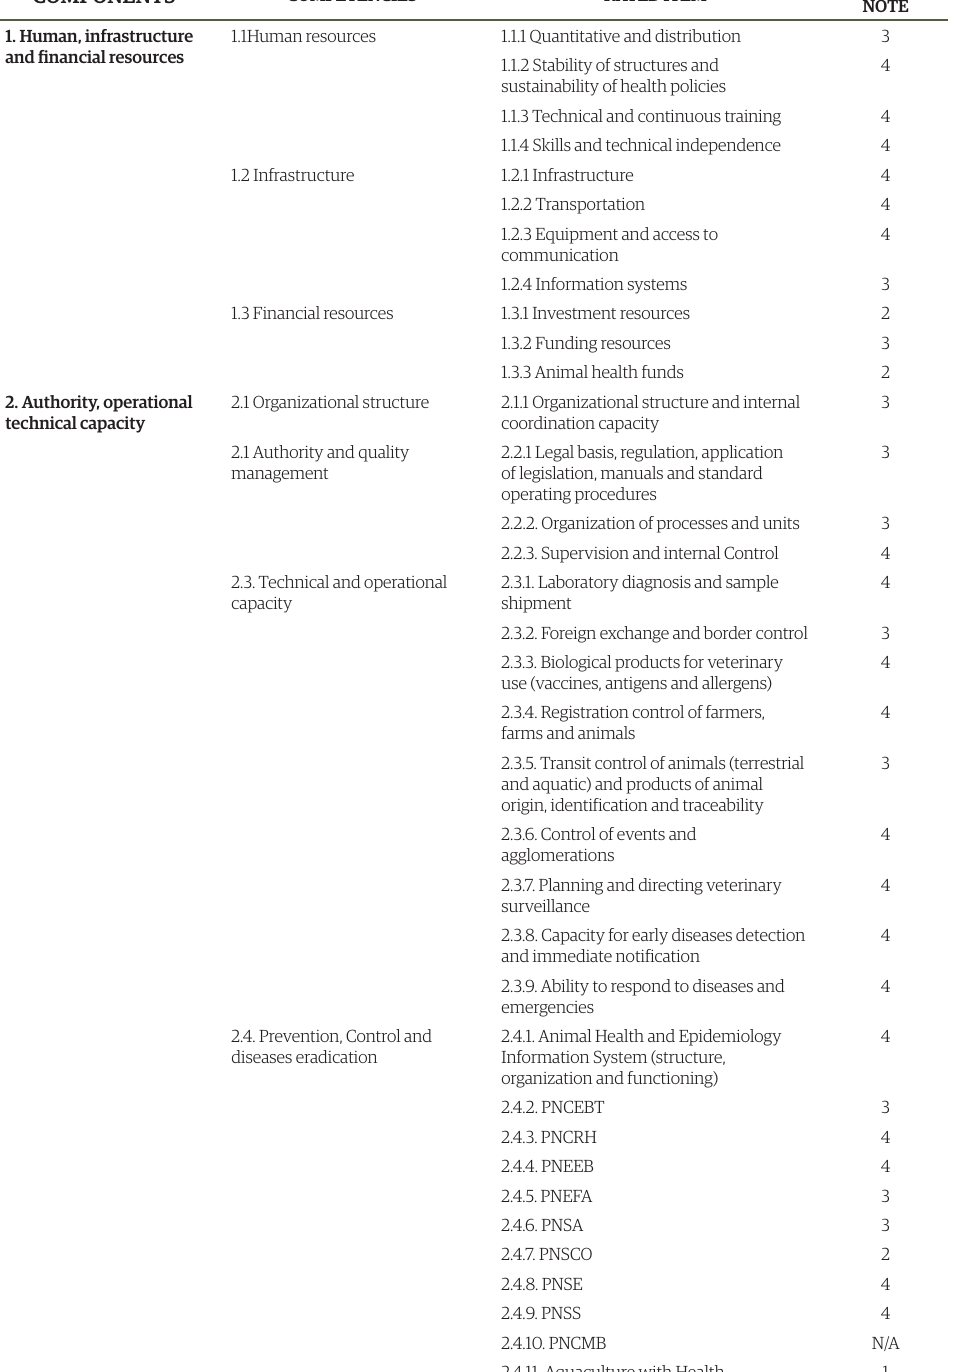
Table 1. QUALI-SV/OIE-PVS auditing data: official veterinary services (OVS), Federal District, Brazil, 2018.